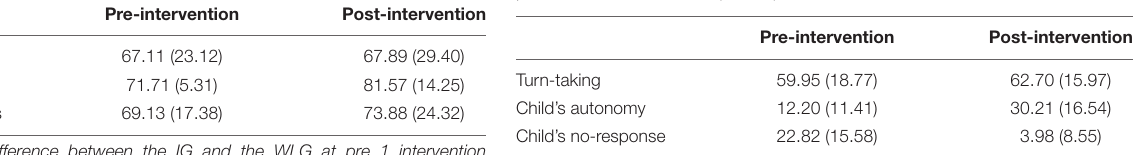
TABLE 4 | Mean (SD) for scores from the Tait video analysis for the three behavioral codes of turn-taking between the parent and the child, child’s communicative autonomy, and child’s no-response, for the pre- and post-intervention sessions ( N =